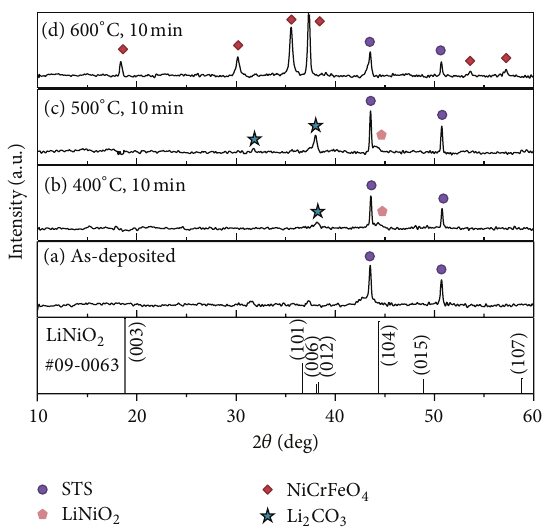
Figure 2: XRD patterns of (a) as-deposited, (b) 400 ∘ C, (c) 500 ∘ C, and (d) 600 ∘ C annealed LiNiO 2 thin films. The annealing time was 10